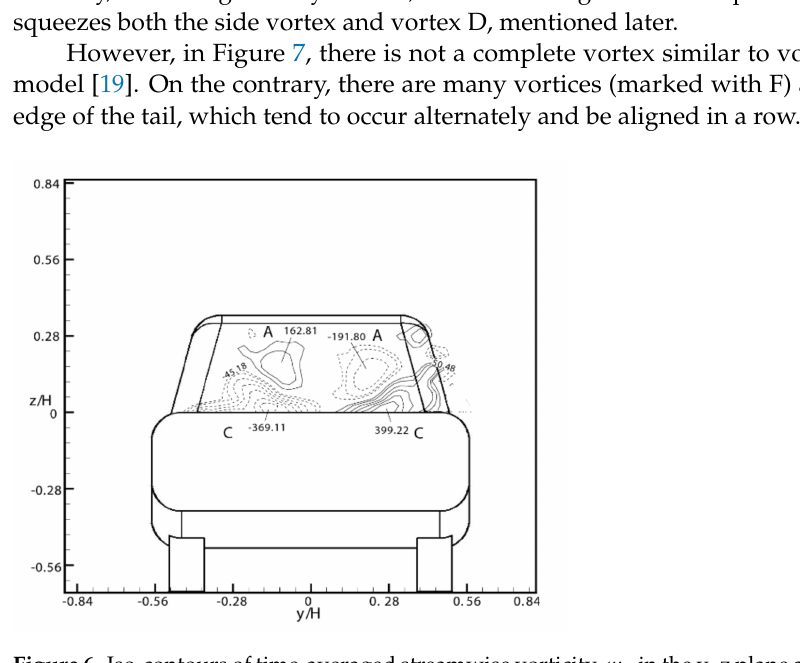
Figure 6. Iso-contours of time-averaged streamwise vorticity, ω x in the y–z plane at x/H = − 0.11. Min- imum and incremental values of vorticity are ω x,min = − 45.178 s − 1 , 50.476 s − 1 , and ∆ ω x = 59.102 s − 1 , respectively.